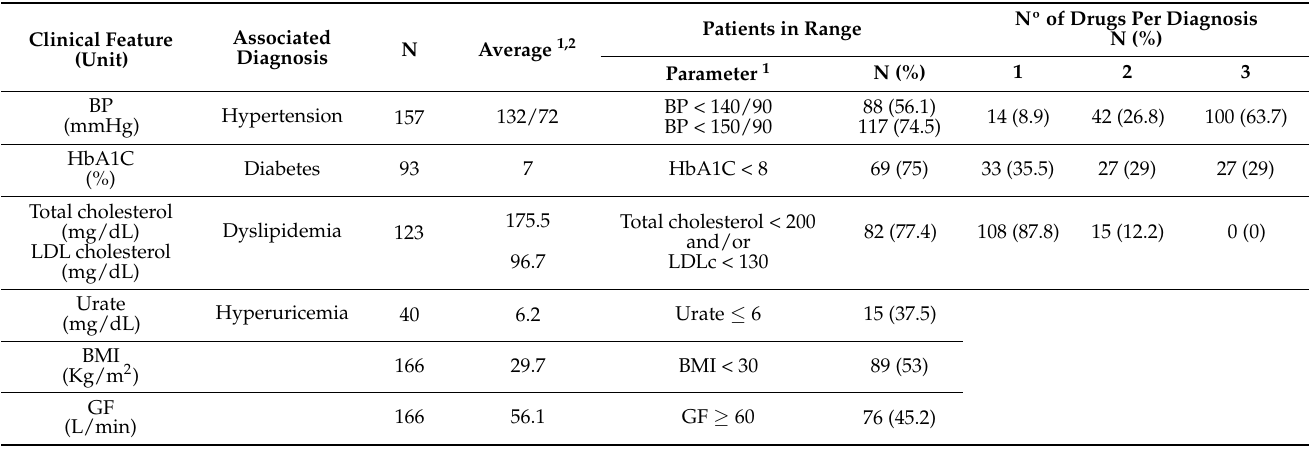
Table 2. Level of control of excessively Polymedicated patients in some of the pathologies.